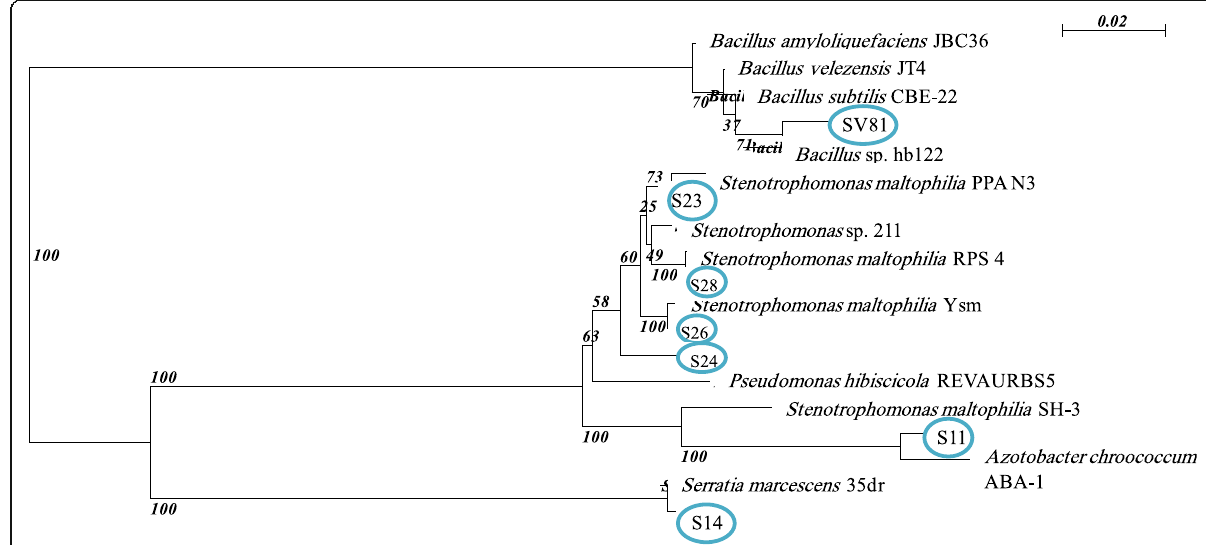
Fig. 4 Neighbor-joining phylogenetic tree of 16S rDNA sequences of SV81, S23, S28, S26, S24, S11, and S14 isolates and their closest phylogenetic relatives. The nucleotide sequences used of representative isolates were obtained from Genbank database under the following